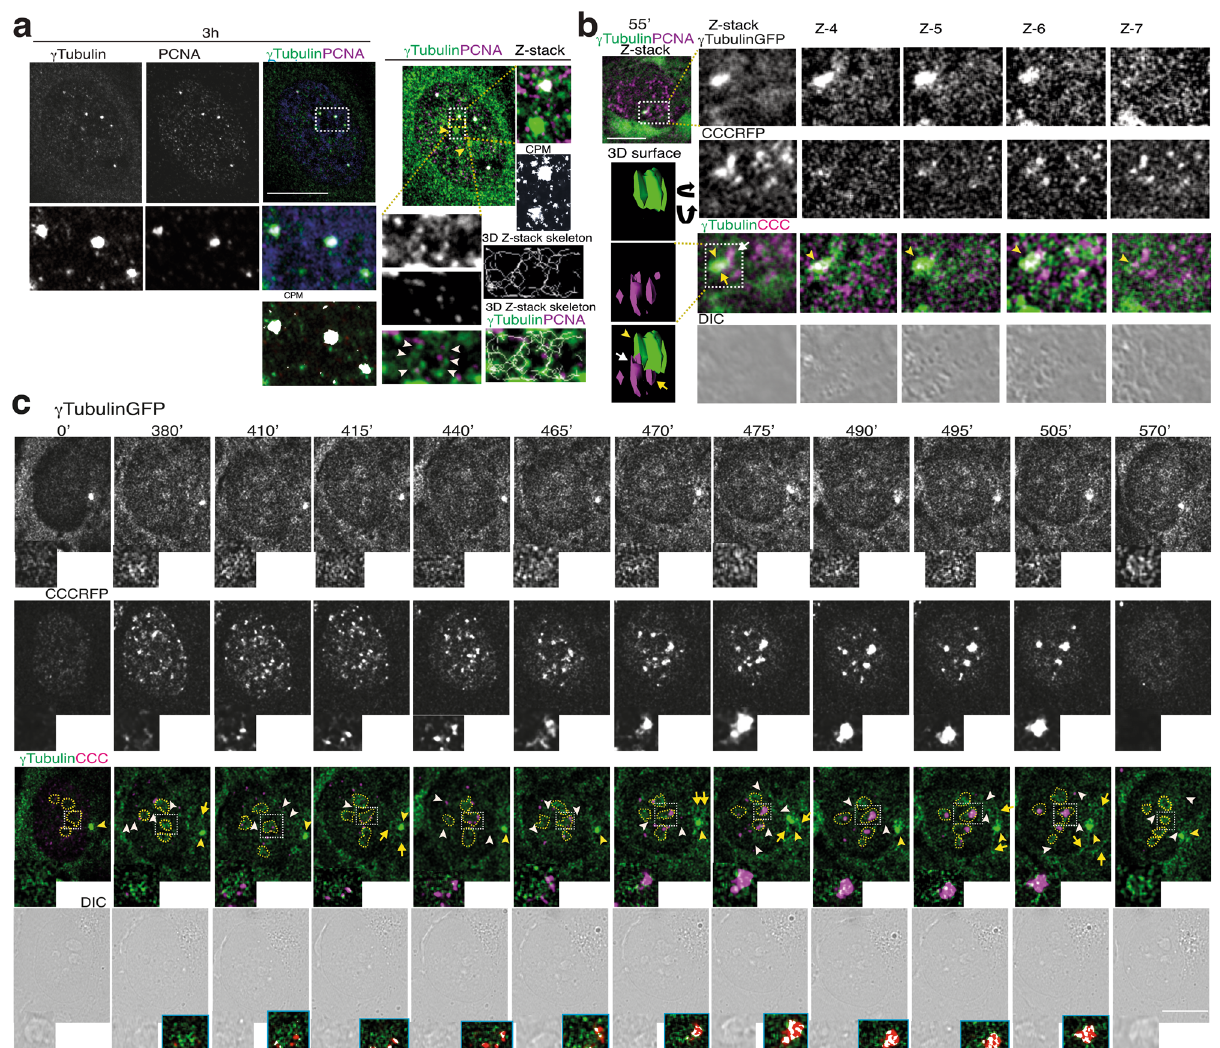
Fig. 5 γ -Tubulin and PCNA accumulates at γ -strings-rich nuclear bodies. a U2OS cells were synchronized in early S phase and then released for 3 h. Localization of endogenous γ -tubulin and PCNA was examined by immuno fl uorescence staining with the indicated antibodies, and nuclei were detected with DAPI. The confocal image shows one plane of the nucleus. a , b Z -stacks show average intensity projection of sequential images ( a 13, b 10) that were collected at 0.2- μ m ( a ) or 0.4- μ m ( b ) intervals. a A 3D thinning algorithm was applied to the Z -stack images from the green channel to fi nd the centerlines